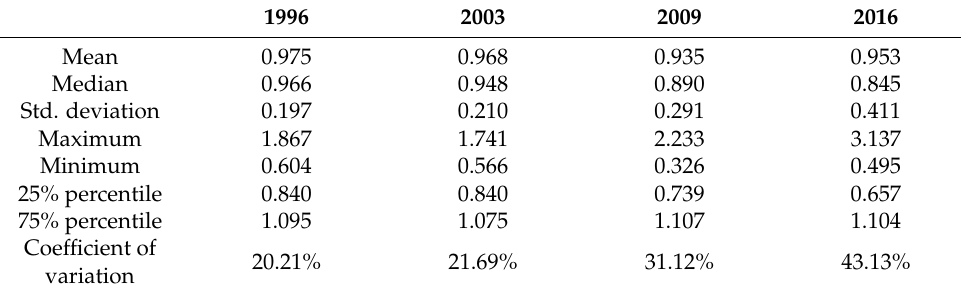
Table 2. Statistical results of STCP from 1996 to